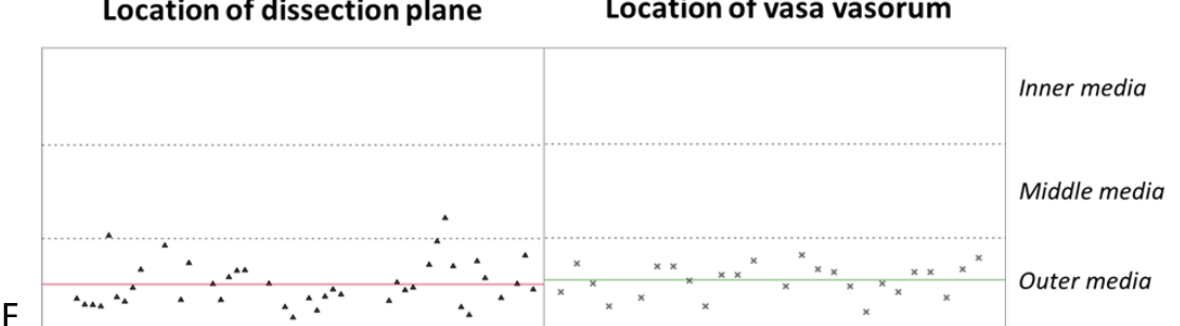
Figure 2. Ratio vasa vasorum. Transverse histologic sections 4 µ m stained for CD31 ( A , B , E ) and MOVAT ( C , D ) in a control patient ( A – E ). A shows an overview of the ascending aorta, with the dashed lines indicating the lamina elastica interna (LEI), with a detailed view of the LEI in B in a CD31 stained section and in C in a MOVAT stained section. The second dashed line ( A ) indicates the lamina elastica externa (LEE), with a detailed view in the MOVAT stained section ( D ). The asterisk indicates the nearest vasa vasorum ( A , E ). The ratio of the vasa vasorum is calculated by dividing the distance between LEI and nearest vasa vasorum (indicated by 1 in A ) by the distance between LEI and LEE (indicated by 2 in A ). The location of the dissection plane is shown on the left and the vasa vasorum on the right in graph F . Each triangle and asterisk ( F ) represents one TAAD patient. The red line represents the median location of the dissection plane, and the green line represents the median location of vasa vasorum. The dashed lines are the borders between the inner, middle, and outer media.